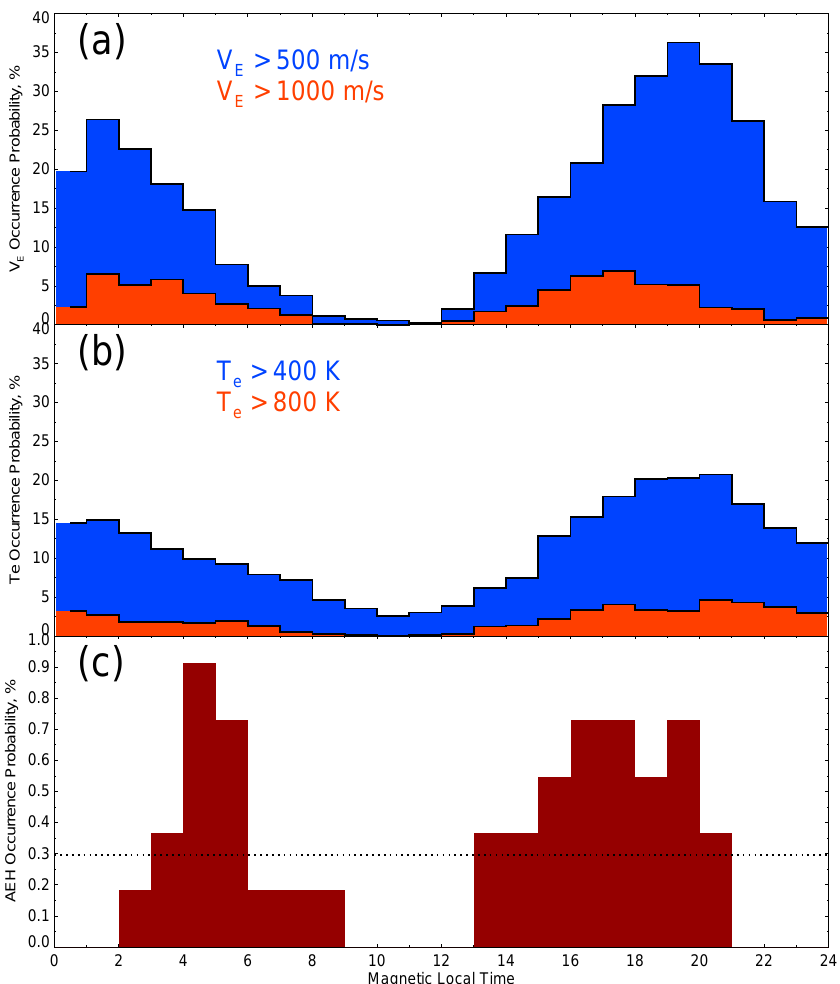
Fig. 5. Occurrence probabilities versus MLT for (a) high convection velocity V E , (b) high electron temperature T e , and (c) AEH hourly intervals. The overall AEH probability of 0.3% is marked by a dotted line in panel (c)